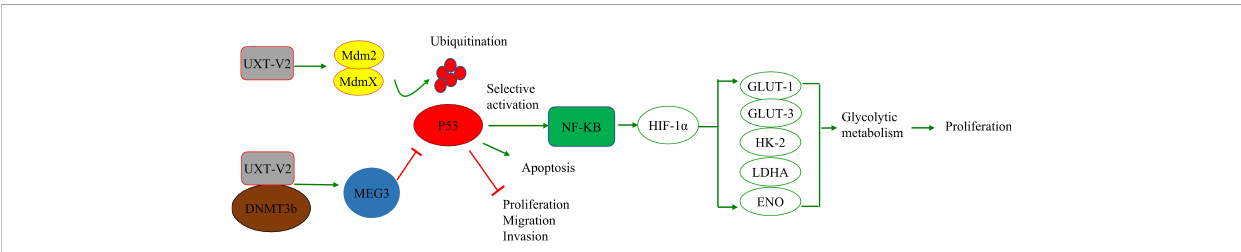
FIGURE 2 UXT and the P53 signaling pathway: UXT-V2 inhibits P53 by promoting ubiquitin degradation of P53 through MDMX. Down-regulation of P53 activity leads to selective activation of NF- k B signaling pathway, up-regulation of HIF-1 a expression, promotion of glycolysis gene GLUT-1/3, HK-2, LDHA, and ENO expression, and promotion of glycolysis. These changes promote cell proliferation. By binding to DNMT3B, UXT-V2 downregulates MEG3 by methylation and thus inhibits the P53 signaling pathway. When P53 is suppressed, apoptosis is inhibited and cell proliferation, migration and invasion are